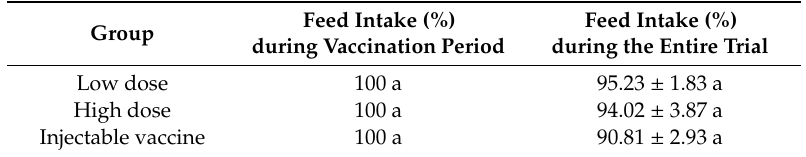
Table 3. Feed intake rates for experimental diets (low dose oral vaccine, high dose oral vaccine, injectable vaccine) during the vaccination period and throughout the trial. Feed Intake (%) Feed Intake (%) Group during Vaccination Period during the Entire Trial